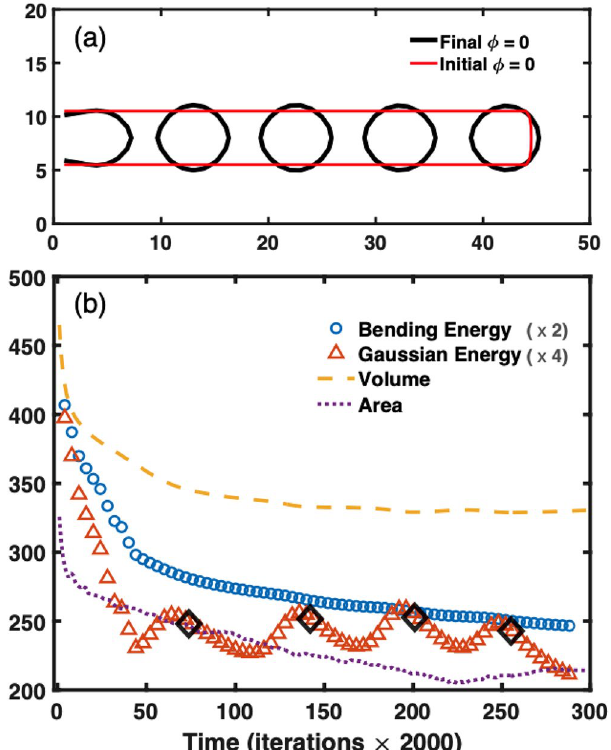
Figure 2. Time evolution of a longer membrane tube with Gaussian curvature. ( a ) Contour plots on the plane 0 configuration. ( b ) Time variations of the volume (yellow dashed x , z of the initial (red) and final (black) φ = line), the area (purple dotted line), the bending energy (open blue circles) and the Gaussian energy (open red triangles). The open black diamonds represent the times when the vesicle is formed. The parameters used were: R 0.5 . 6 and L 45 , ε 1 , κ 10 and C 0 ′ = − = − = = =